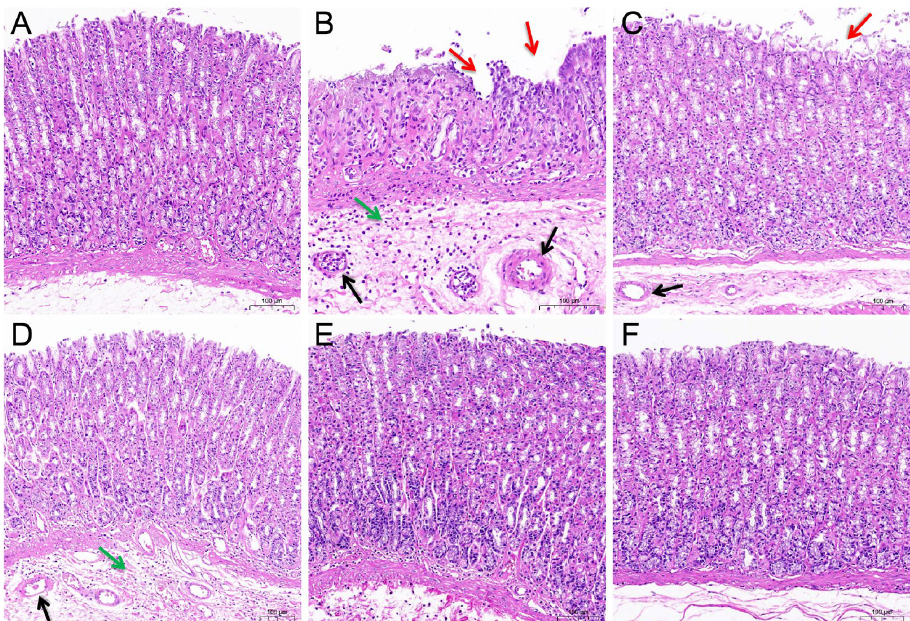
Figure 9. Results of gastric H&E section. ( A ) Control group. ( B ) Model group. ( C ) Ranitidine group. ( D ) ARE 0.15 g/kg group. ( E ) ARE 0.3 g/kg group. ( F ) ARE 0.6 g/kg group. ARE, Aucklandia Radix ethanol extract. The red arrow indicates epithelial cell loss, the green arrow indicates inflammatory exudation and infiltration, and the black arrow indicates vasocongestion.